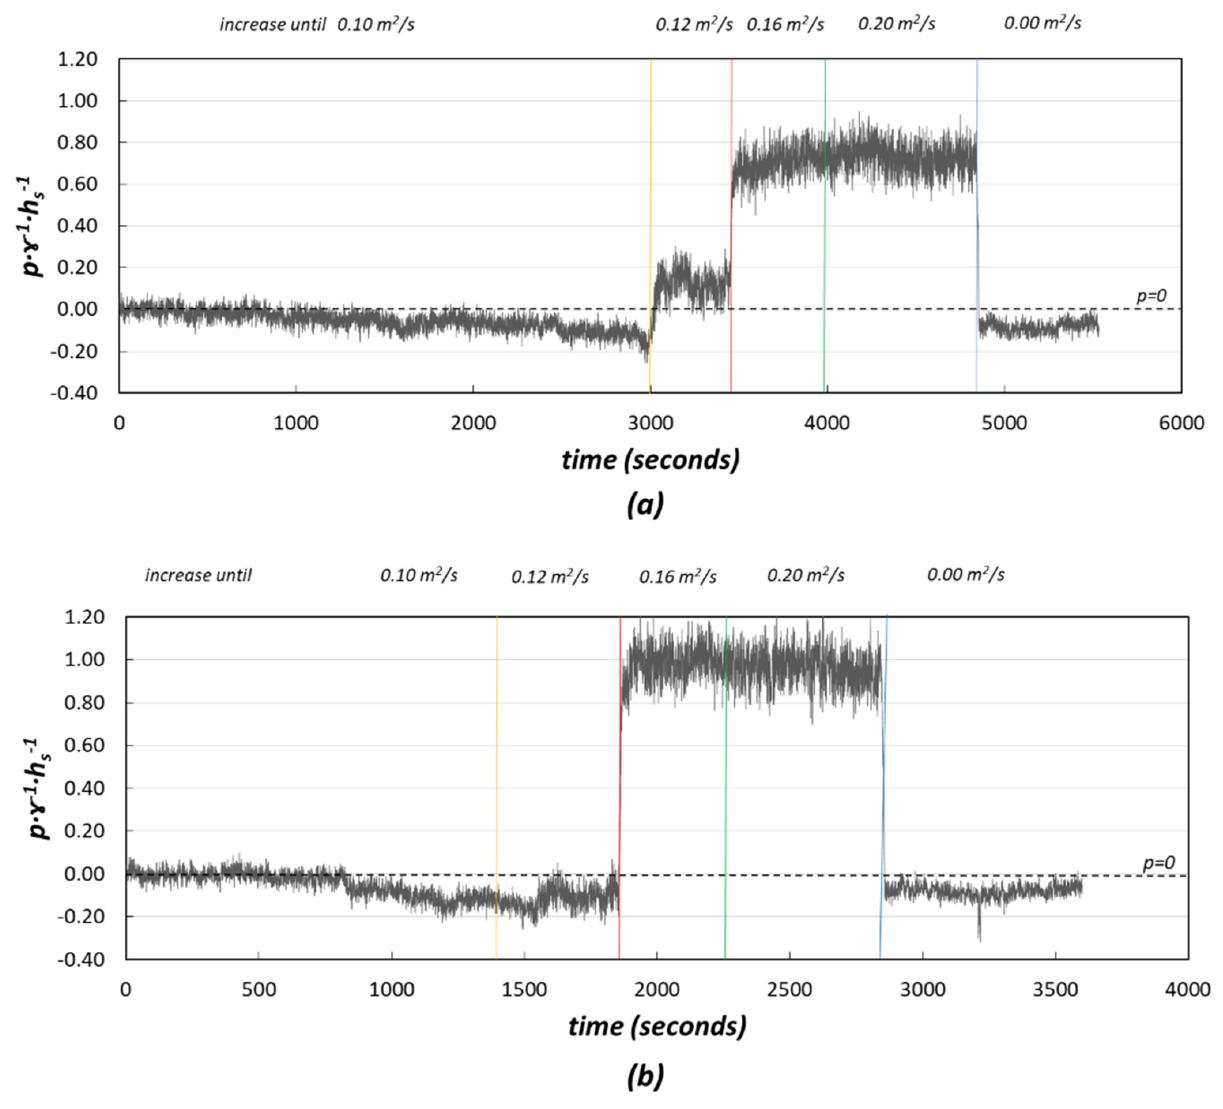
Figure 21. Hydrodynamic pressures on the base of the Armorwedge TM block ( w 1) ( a ) and ACUÑA block ( w 2) ( b ) in row 25 for unit flow rates ( q ). Pressures range from 0.04 to 0.24 m 2 s − 1 and a decrease to zero discharge.